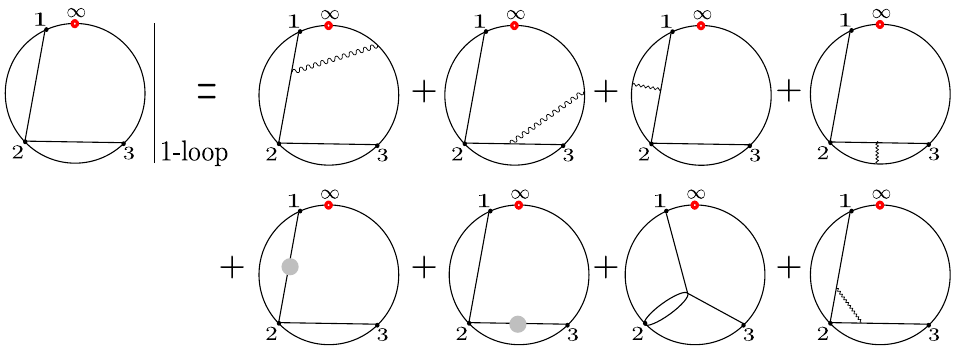
Figure 9 . The one-loop corrections to the three-point function with L 1 = L 2 = 2 ; L 3 = 1. The (cid:12)nal result is given by